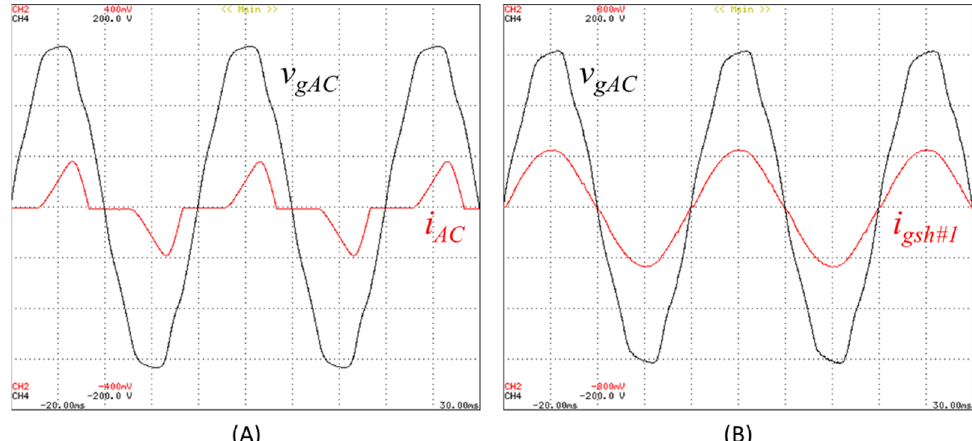
Figure 8. Experimental results showing the operation of a front-end AC/DC converter: ( A ) Voltage (100 V/div) of the main AC grid and consumed current (5 A/div) in the AC grid of the hybrid AC/DC grid; ( B ) Voltage (100 V/div) of the main AC grid and total current (10 A/div) consumed by the hybrid AC/DC smart home.